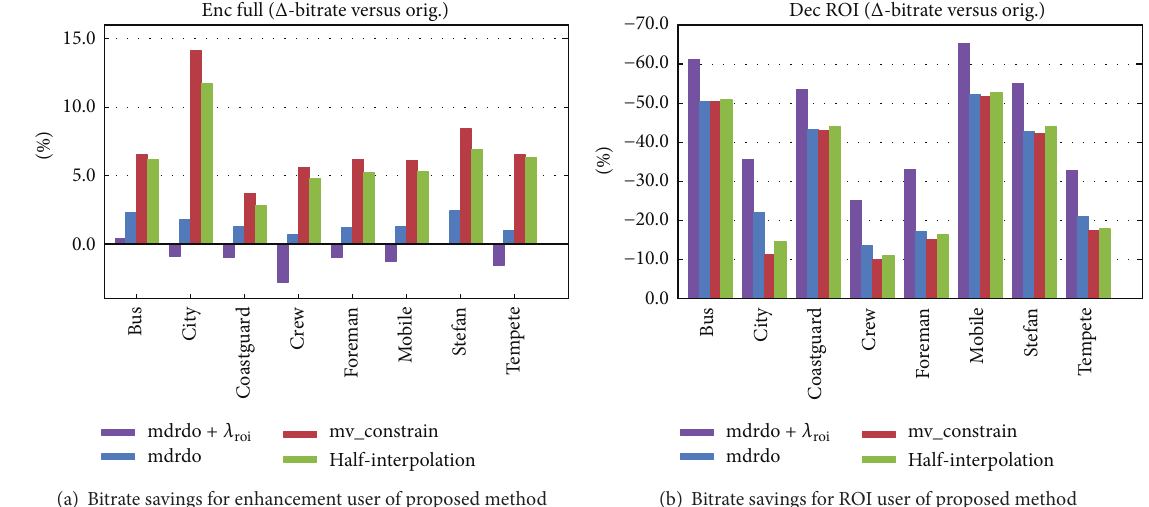
Figure 10: RD performance for spatial SVC with proposed RDO